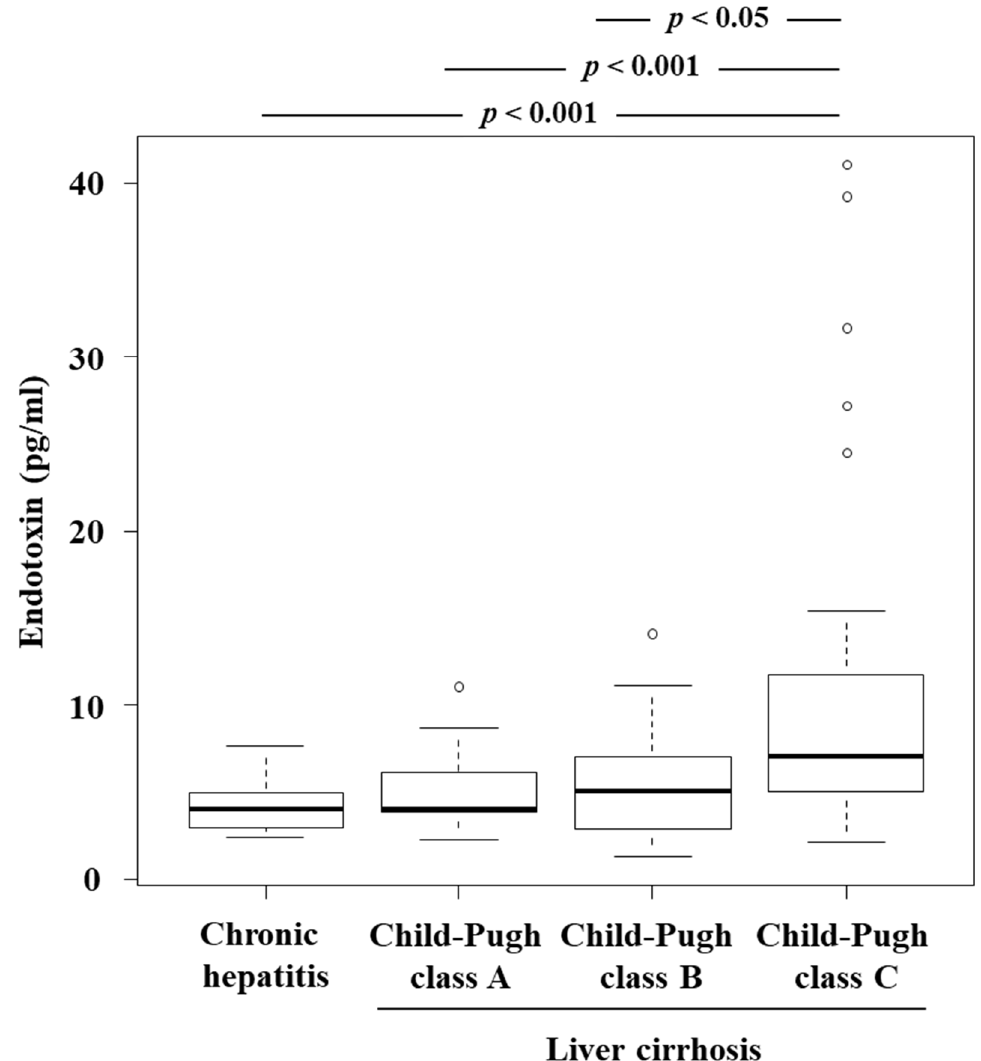
Figure 3. Relationship between endotoxin levels and liver cirrhosis. Endotoxin levels increased as LC progressed and were highest in patients with Child–Pugh class C cirrhosis ( p < 0.001 for between Child–Pugh classes C and A or chronic hepatitis, and p < 0.05 for between Child–Pugh classes C and B). Box plots represent, from top to bottom, sample maximum, upper-quartile range, median and lower-quartile range, and sample minimum. LC, liver cirrhosis.